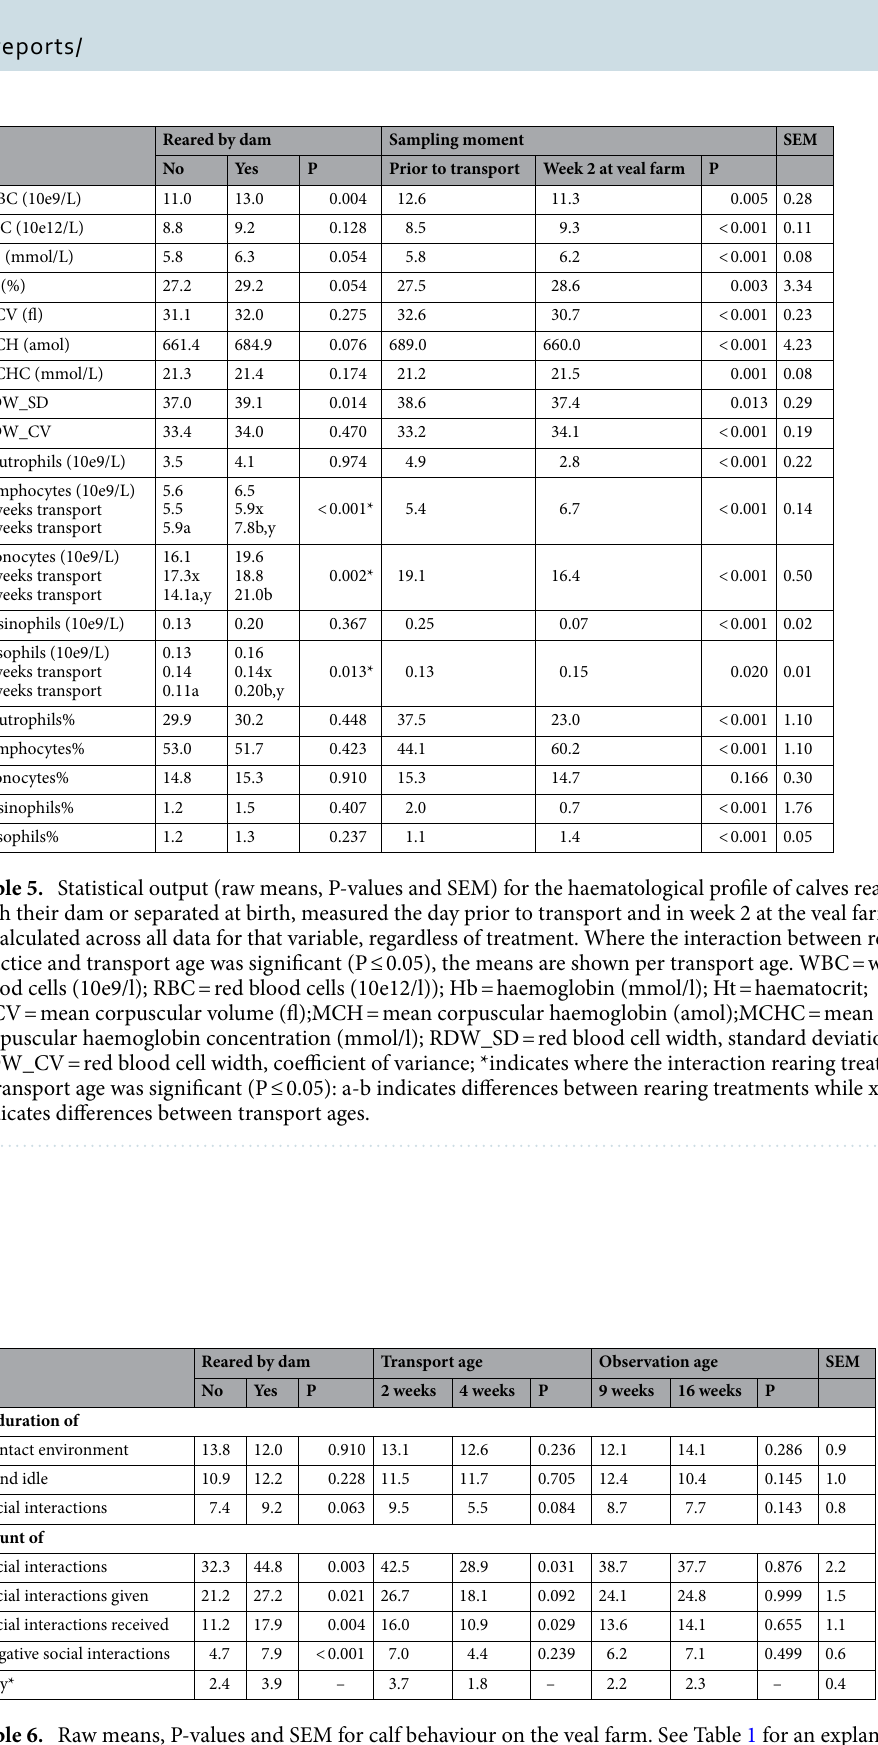
Table 6. Raw means, P-values and SEM for calf behaviour on the veal farm. See Table 1 for an explanation of which behaviours are included in each category below. SEM is calculated across all data for that variable, regardless of treatment. *Play model did not converge due to too many zeros in the